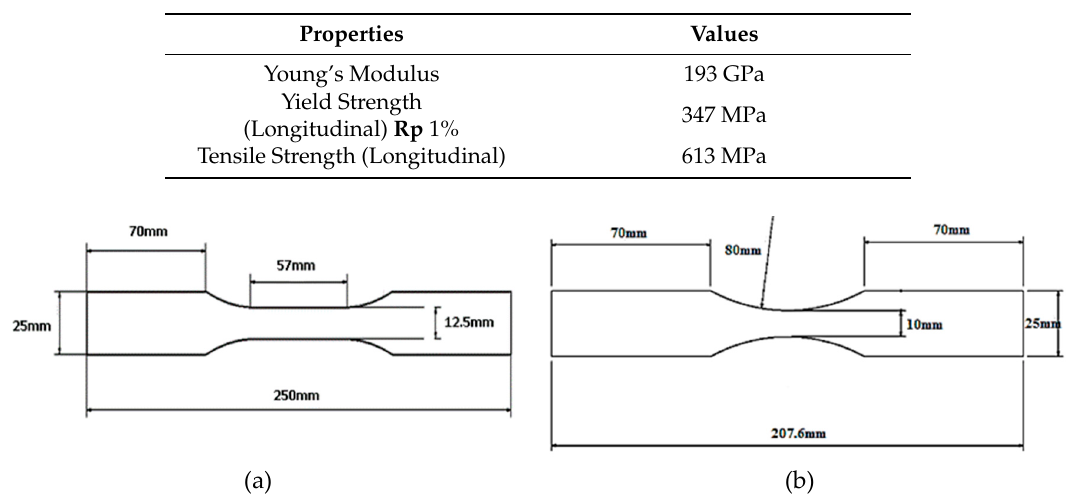
Table 4. Mechanical Properties.